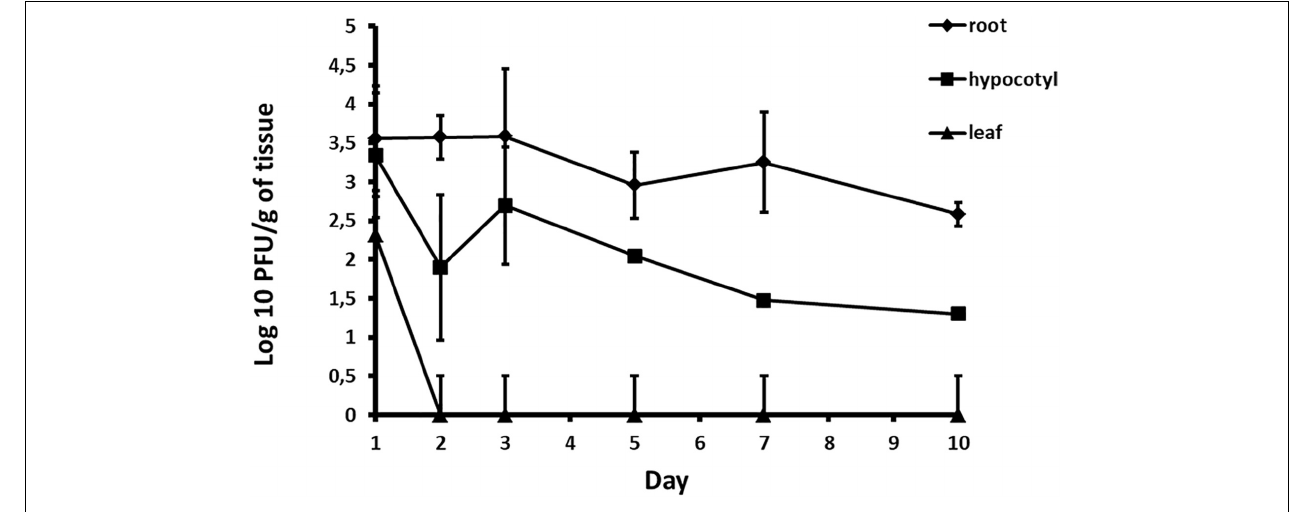
FIGURE 10 | Quantification of phage translocation through plant tissue. The results shown are mean values of three replications with standard deviations.